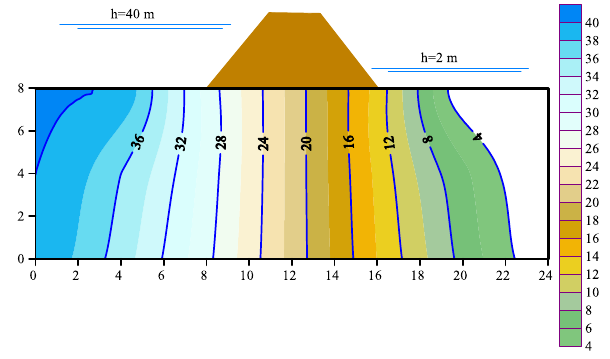
Fig. 9 Contours of hydraulic head (m) for the second problem with 21 nodes